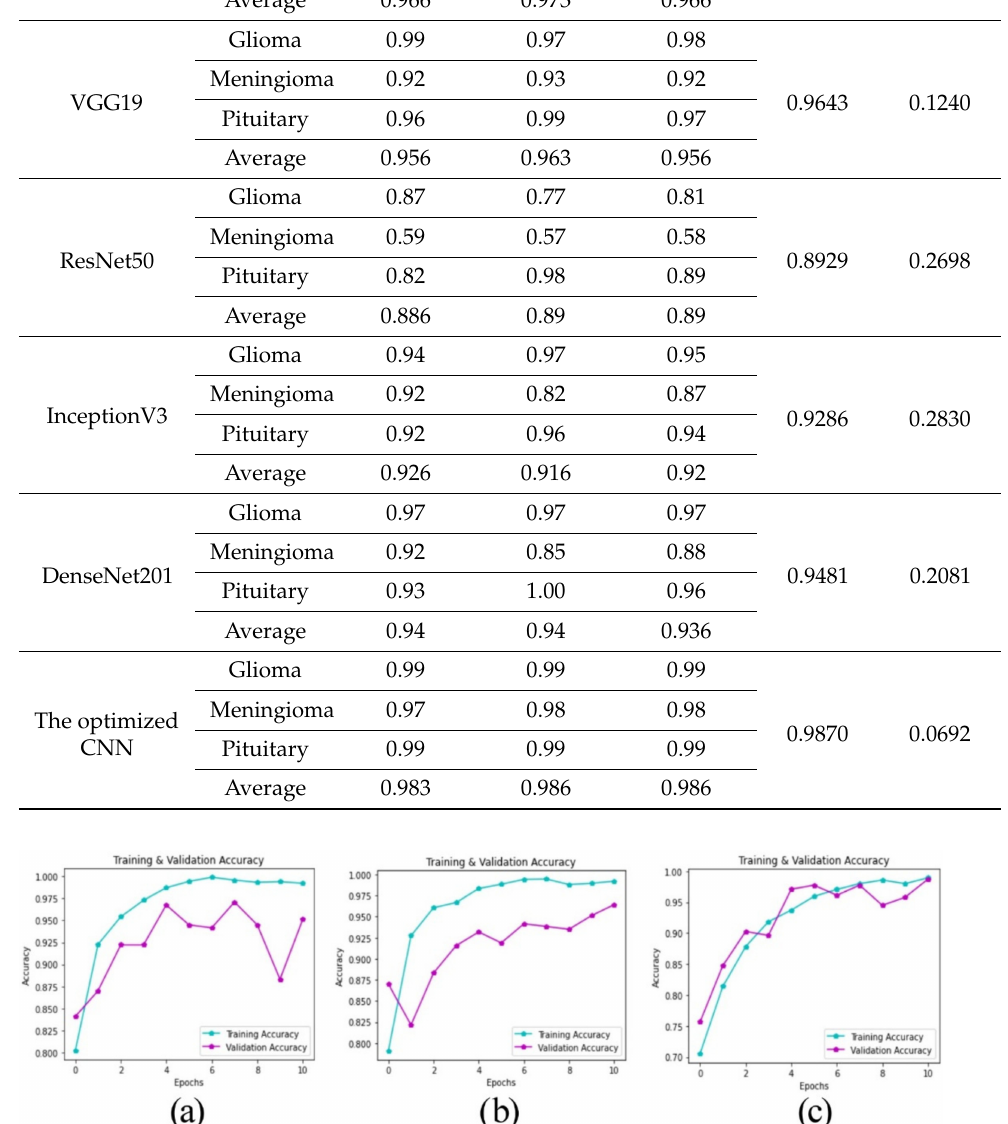
Figure 15. Accuracy plots (training and validation). ( a ) VGG16. ( b ) VGG19. ( c ) The optimized